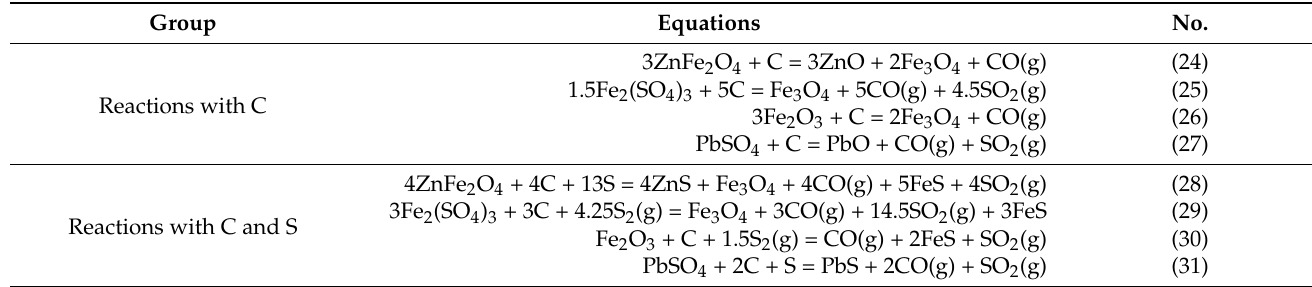
Table 5. Equations of jarosite-PbAg sludge with carbon and with carbon and sulfur. Group Equations